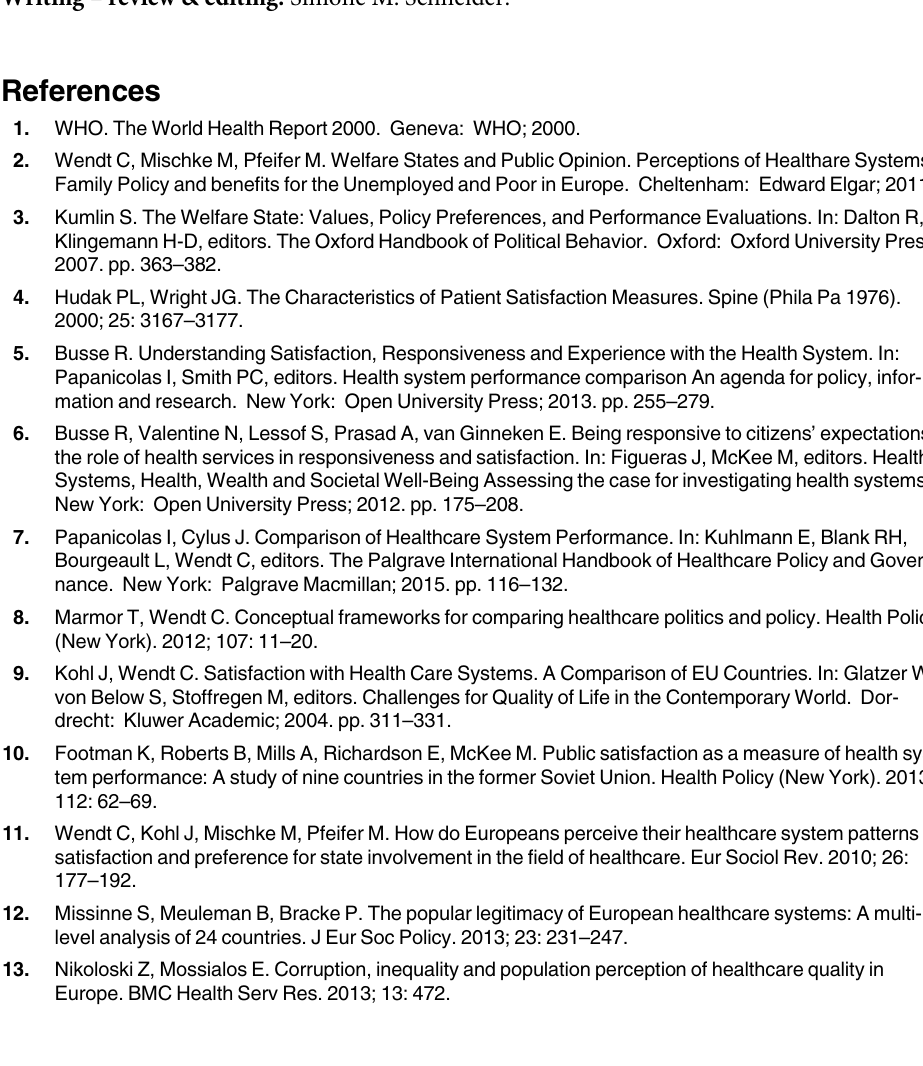
S5 Table. Effects of institutional healthcare characteristics on healthcare ratings–with varying cluster sizes at group